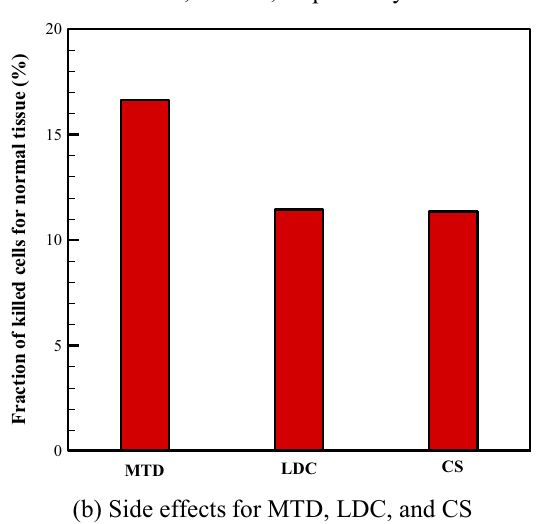
Figure 1. Survival rate of tumor cells and also side effects for different treatment approaches including MTD, LDC, and CS. These treatment approaches are defined as: (i) injected dose = C p and interval between treatments = 0.5-month (for MTD); (ii) injected dose = 0.2 C p , and interval between treatments = 0.1-month (for LDC); and (iii) injected dose of C p and a 0.5-month break and then five administrations of 0.2 C p and a 0.1-month break (for CS). It should be noted that side effect is a secondary unwanted effect that occurs due to drug therapy. Here, side effects are defined as the impact of chemotherapeutic drug on the cells of healthy tissue around the